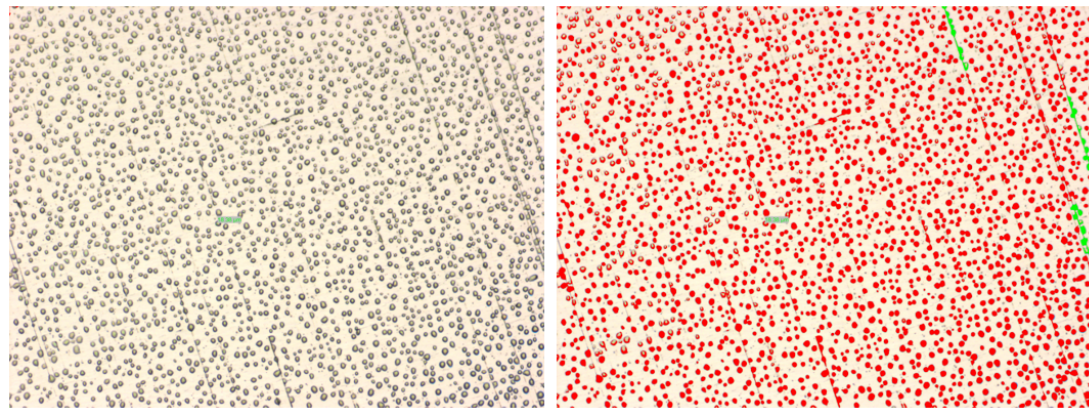
Figure 5. Fog particle analysis at × 200